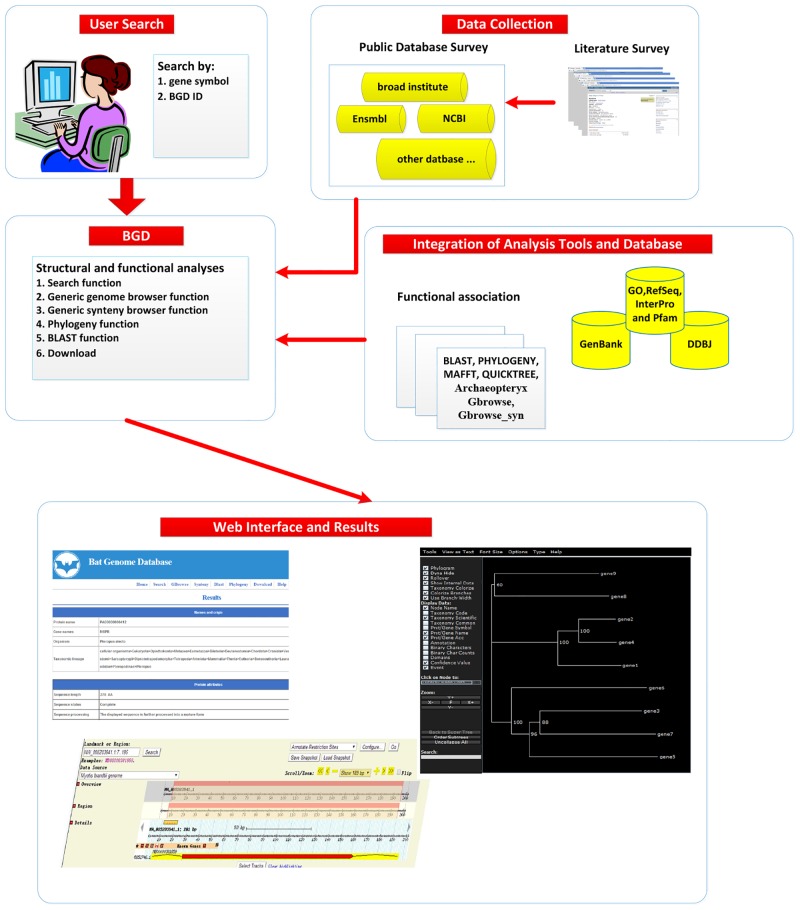
System flow of BGD.